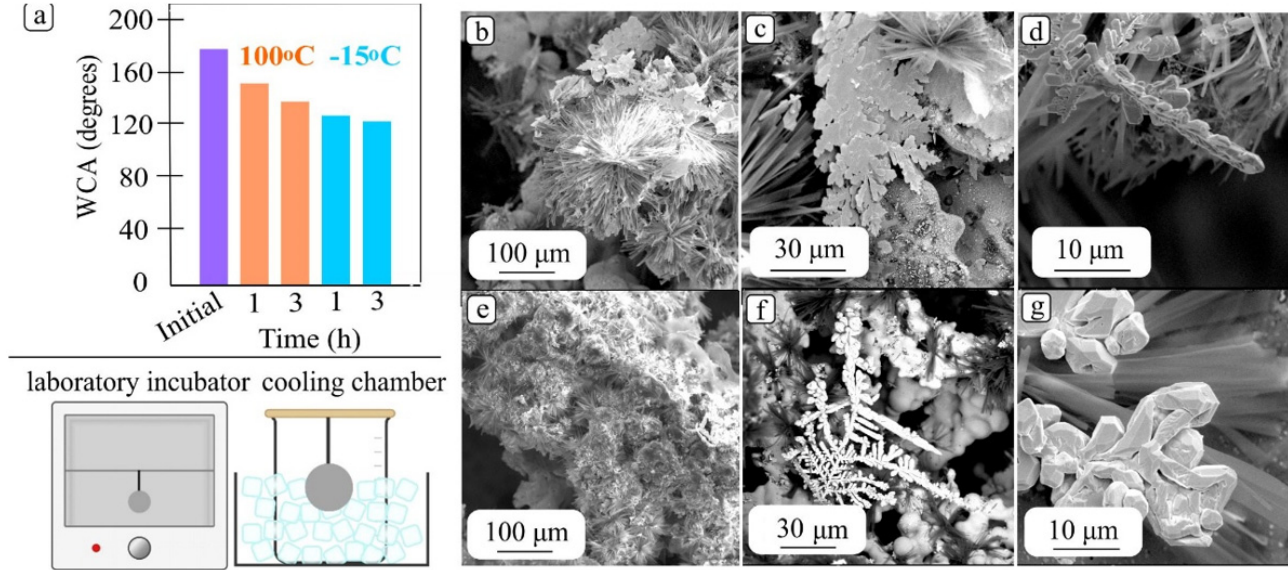
Figure 8. ( a ) WCA measurements after thermal treatment in 100 ◦ C and − 15 ◦ C. SEM images of morphologies after thermal treatment ( b – d ) after 1 h in − 15 ◦ C, ( e – g ) after 1 h in 100 ◦